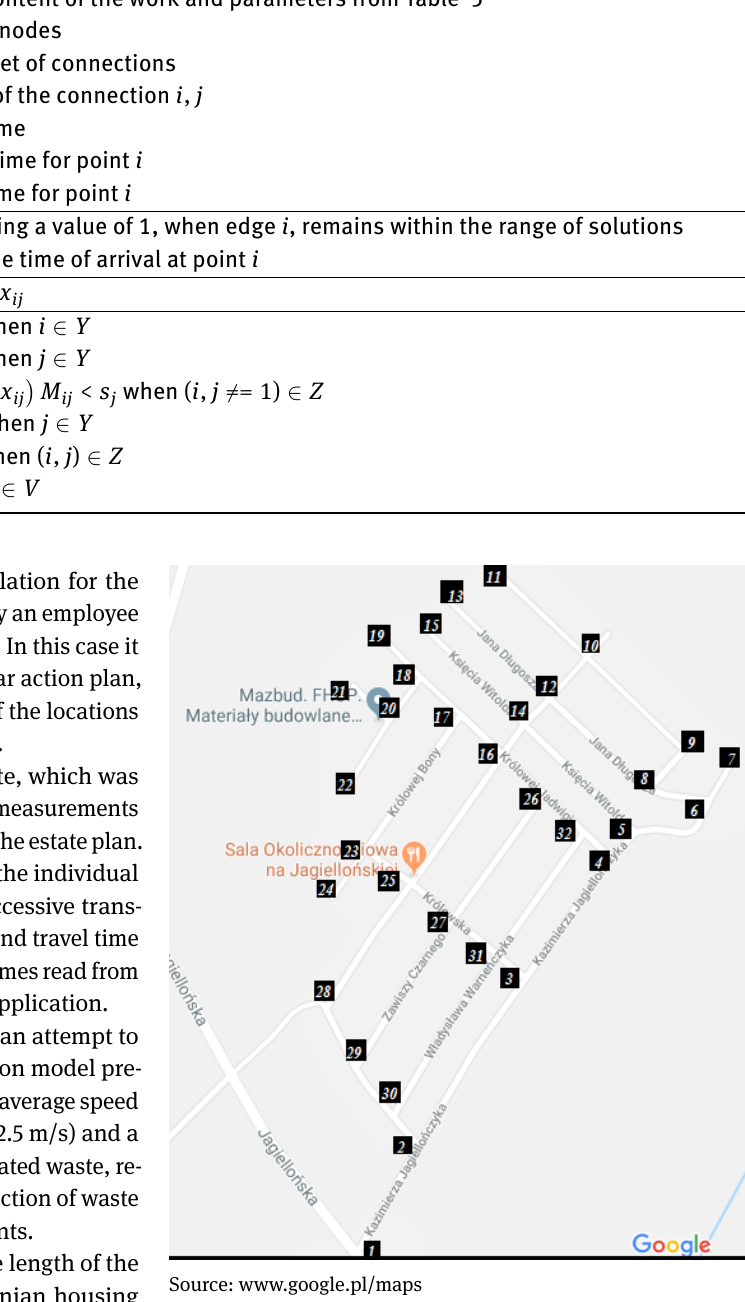
Figure 10: Visualization of the Jagiellońska housing estate (route